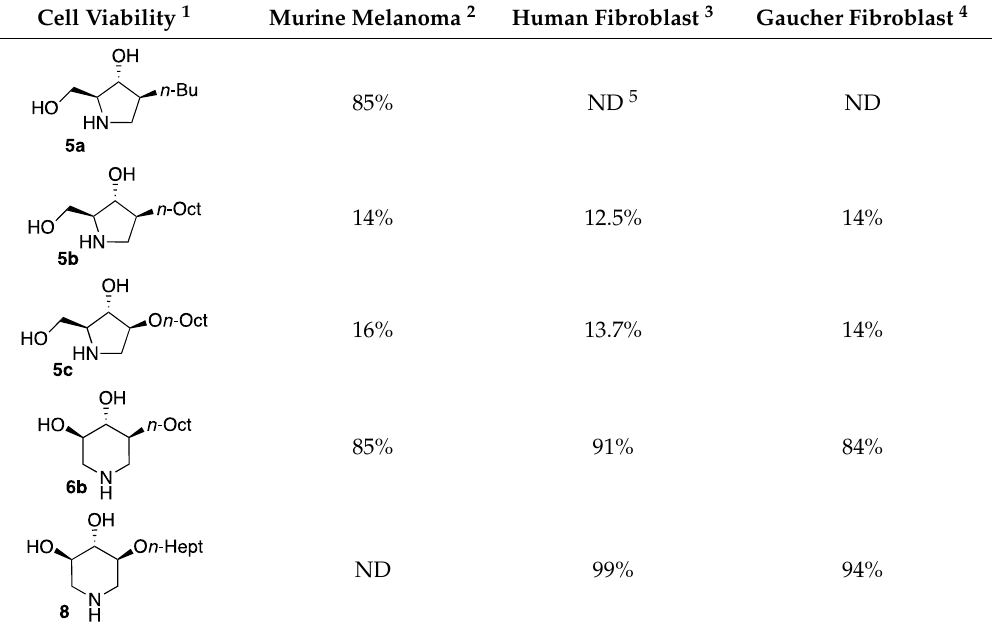
Table 1. Effect of iminosugars on cell Table 1. Effect of iminosugars on cell viability. Table 1. Effect of iminosugars on cell viability. Table 1. Effect of iminosugars on cell viability. Table 1. Effect of iminosugars on cell viability. Table 1. Effect of iminosugars on cell viability.